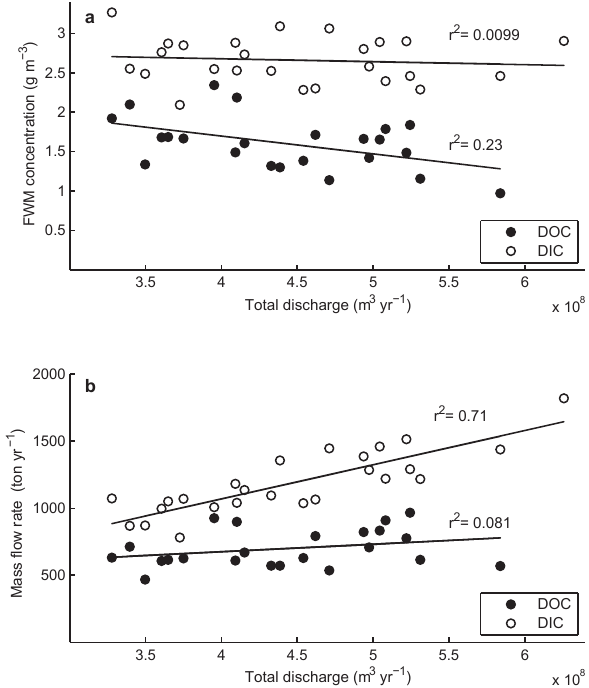
Fig. 8. Dissolved carbon discharge relationships. (a) Annual flow- weighted mean (FWM) of DOC and DIC versus annual discharge at the outlet of Abiskojokken catchment. (b) Annual mass flow rate of DOC and DIC versus annual discharge at the outlet of Abiskojokken catchment; the relation between mass flow rate, S , and mass flux, s , is as shown in Fig.